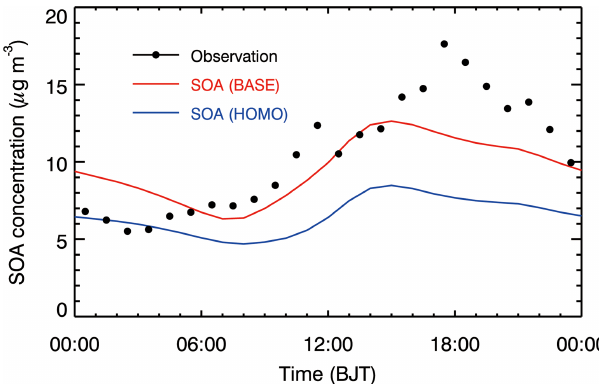
Figure 5. Observed (black dots) and modeled (solid red and blue lines for the BASE and HOMO cases, respectively) SOA diurnal cycle averaged from 9 to 26 January 2014 at the IRSDE site in Bei-